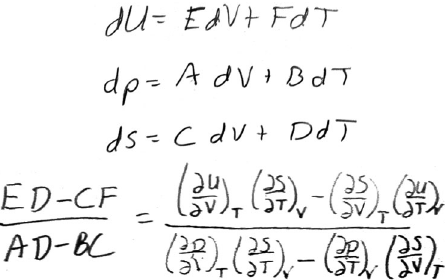
FIG. 1. C. A. M.’s use of letters as placeholders for explicit derivatives and her solution (see Table